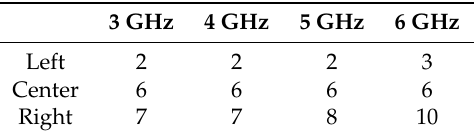
Table 2. The beamwidth of recovered signals at all